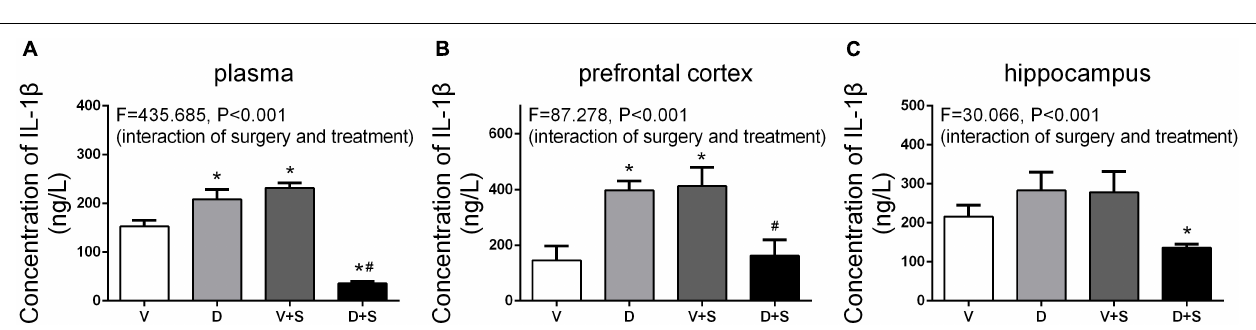
FIGURE 6 | Peripheral and central concentrations of interleukin-6 (IL-6). DSP-4 treatment increased the level of plasma IL-6 under physiological and pathological conditions at 6 h after the surgery (A) , while the concentration of IL-6 showed no significant change at 1 week after the surgery (B) . At 1 week postoperatively, DSP-4 treatment increased the concentration of IL-6 in the prefrontal cortex (C) and hippocampus (D) under physiological conditions and decreased it under pathological conditions. The data are presented as the means ± SEM for each group ( n = 4 per cohort). * p < 0.05 compared to Group V, # p < 0.05 compared to Group V + S.